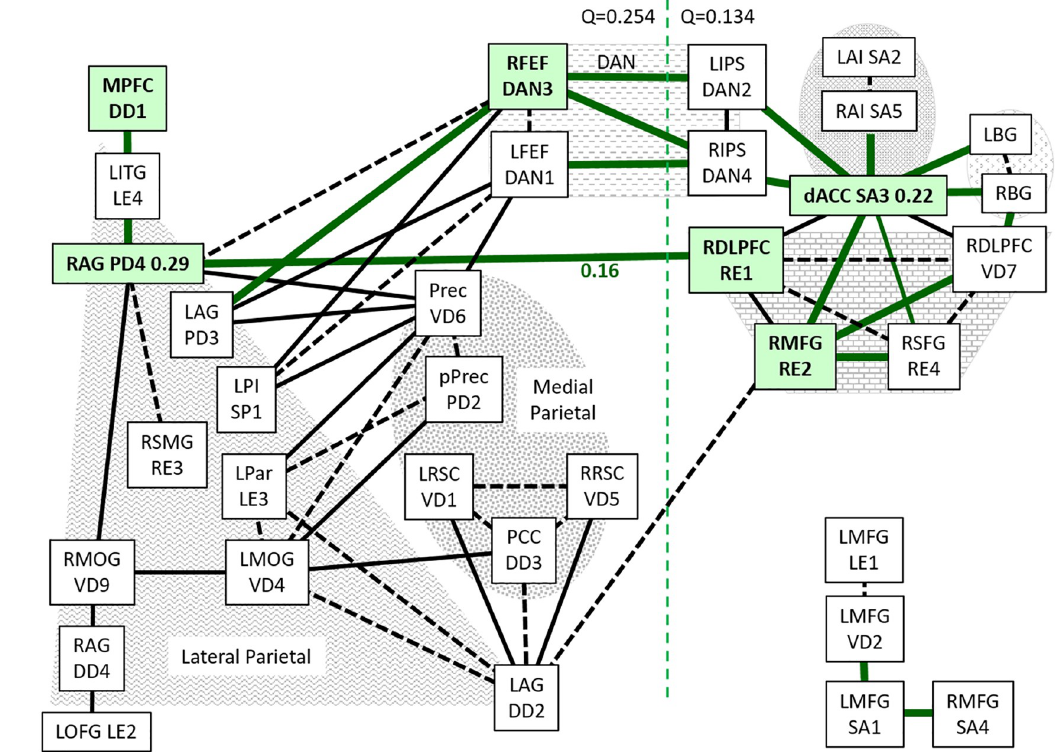
Fig 4. 0-back connectivity in START. All edges with d > 1.6 and FDR < 0.01 for START were plotted as described for Fig 2. The shaded nodes had particular relevance for the START group. The RE1—PD4 edge had high betweenness centrality (0.16). The dotted line separated task and default